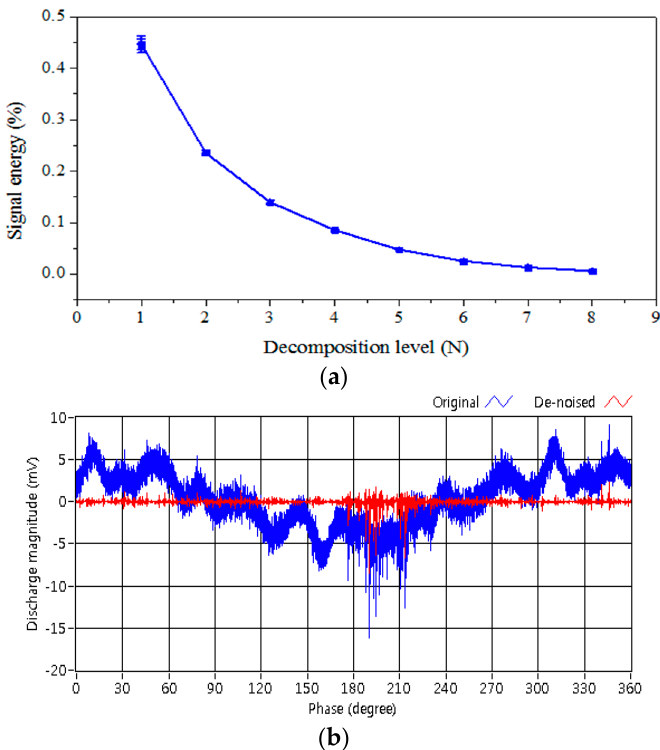
Figure 11. Disturbance elimination for PRPD in the POS. ( a ) Signal energy distribution; ( b ) extraction of PRPD.